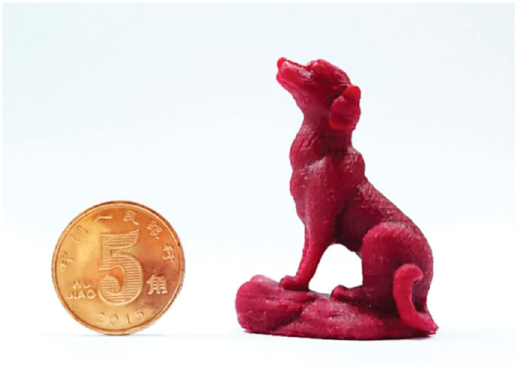
Figure 9. Digital picture of secondary thiol-ene (PE-1/TTT) photosensitive resin after DLP printing. Reproduced from [223] with permission from the Royal Society of Chemistry.